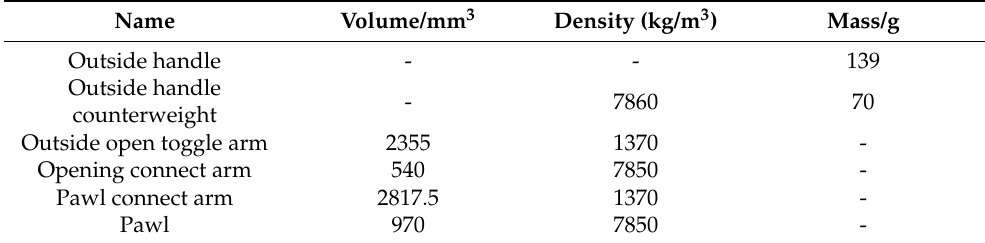
Table 3. Parts Table 3. Parts parameters.